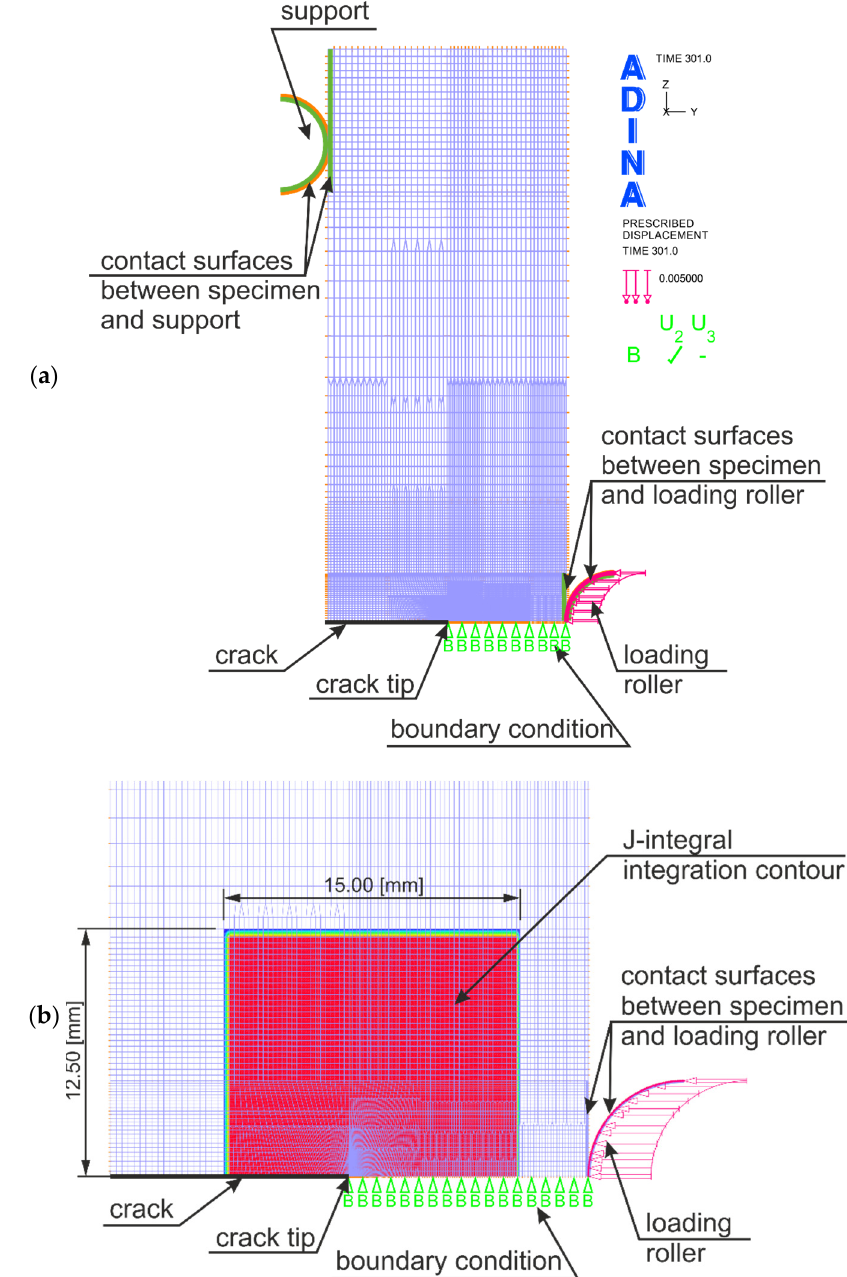
Figure 3. Numerical model of the SEN(B) specimen used in numerical calculations simulating the crack growth: ( a ) model of the whole specimen, and ( b ) enlargement of the area at the top of the crack, along with the designation of the integration contour required for the numerical estimate of the value of the J ‐ integral.